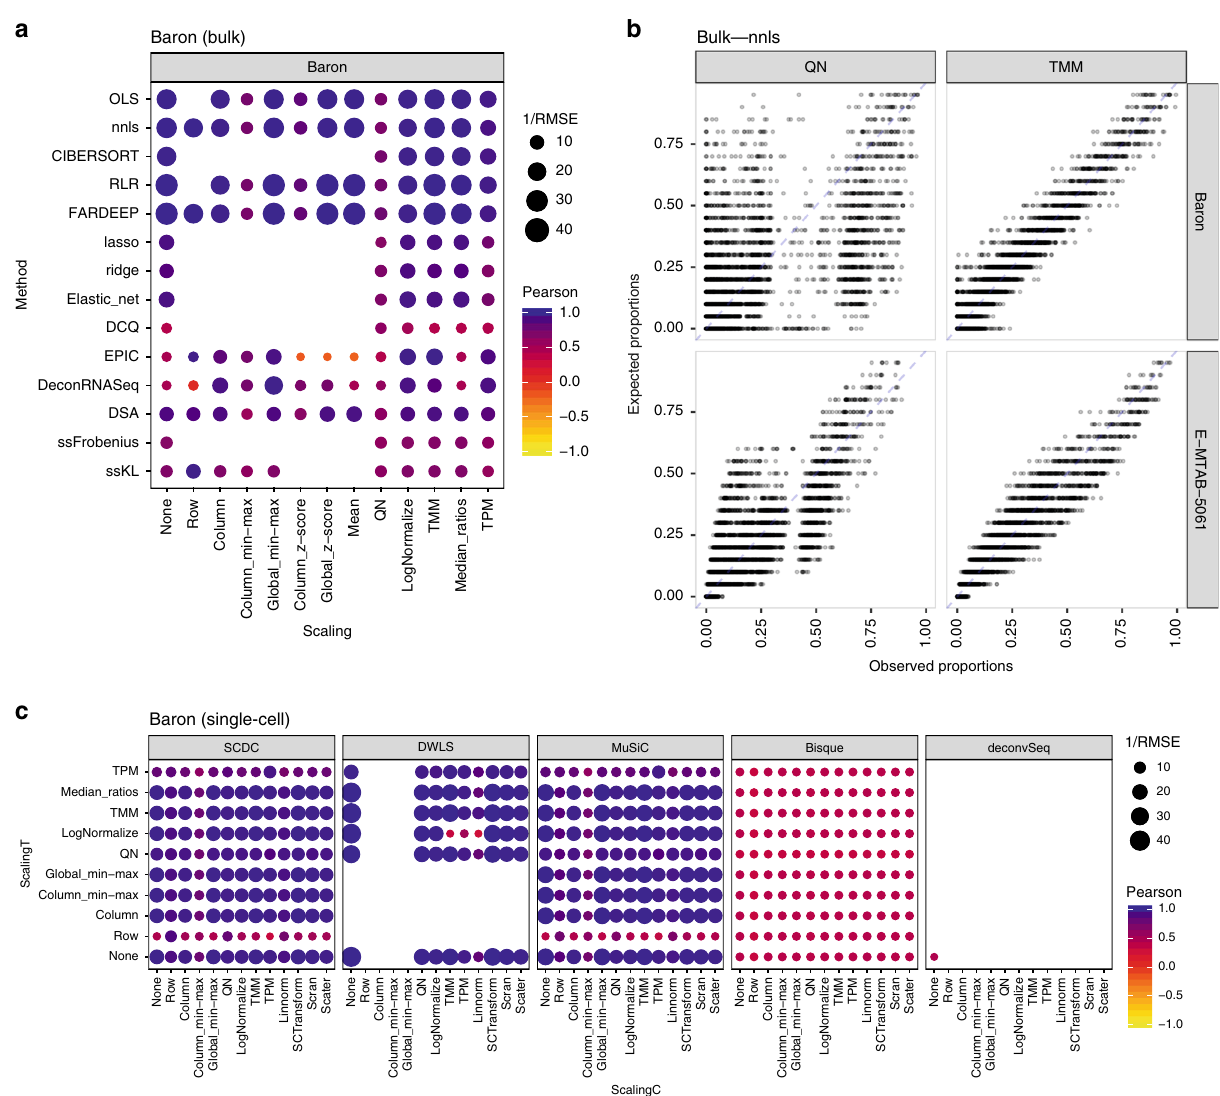
Fig. 3 Combined impact of data normalization and methodology on the deconvolution results. RMSE and Pearson correlation values between the expected (known) proportions in 1000 pseudo-bulk tissue mixtures in linear scale (pool size = 100 cells per mixture) and the output proportions from the different bulk deconvolution methods ( a ) and those using scRNA-seq data as reference ( c ). The darker the blue and the higher the area of the circle represents higher Pearson and lower RMSE values, respectively. b Scatter plot showing the impact of the normalization strategy (TMM versus quantile normalization (QN)) comparing the expected proportions ( y -axis) and the results obtained through computational deconvolution using nnls ( x -axis) for Baron and E-MTAB-5061 datasets. Empty locations represent combinations that were not feasible (see Supplementary